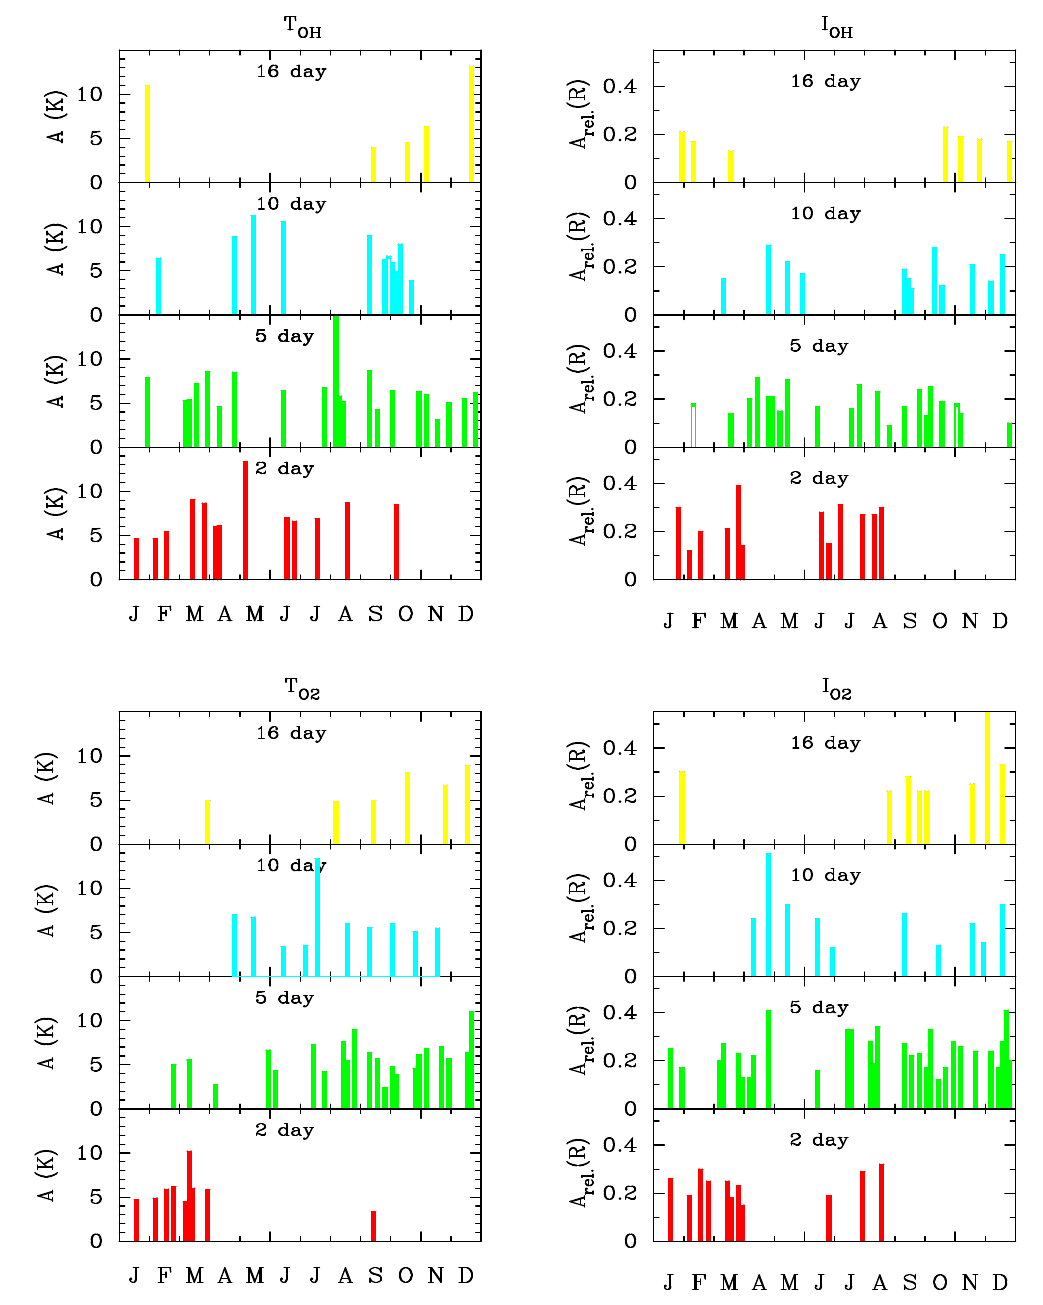
Fig. 4. Amplitudes of planetary wave type oscillations identified as function of the month.